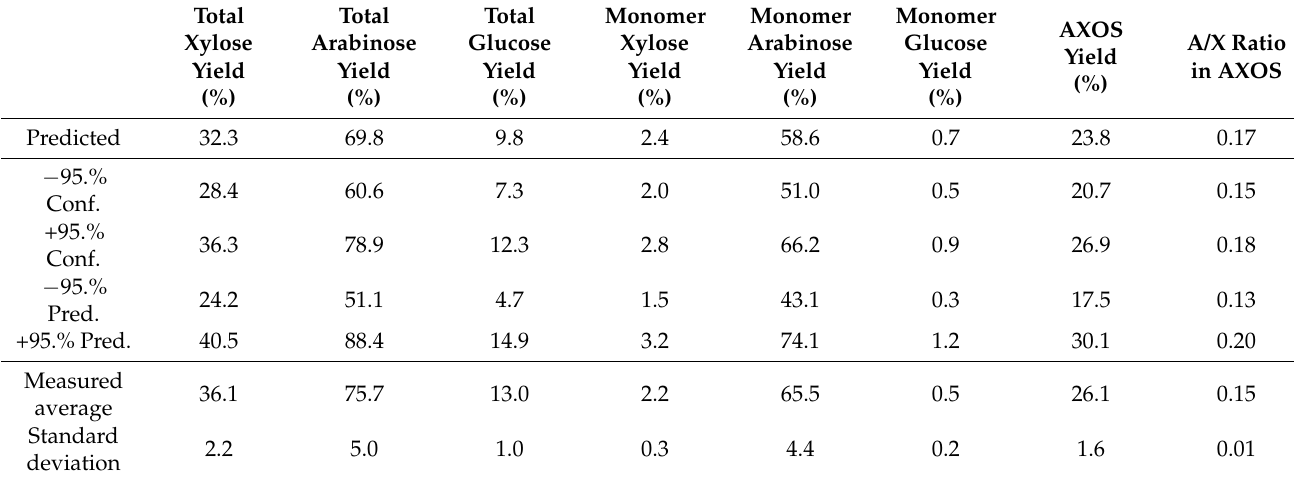
Table 3. Model predictions and experimental results of the first acidic hydrolysis of BSG under optimised